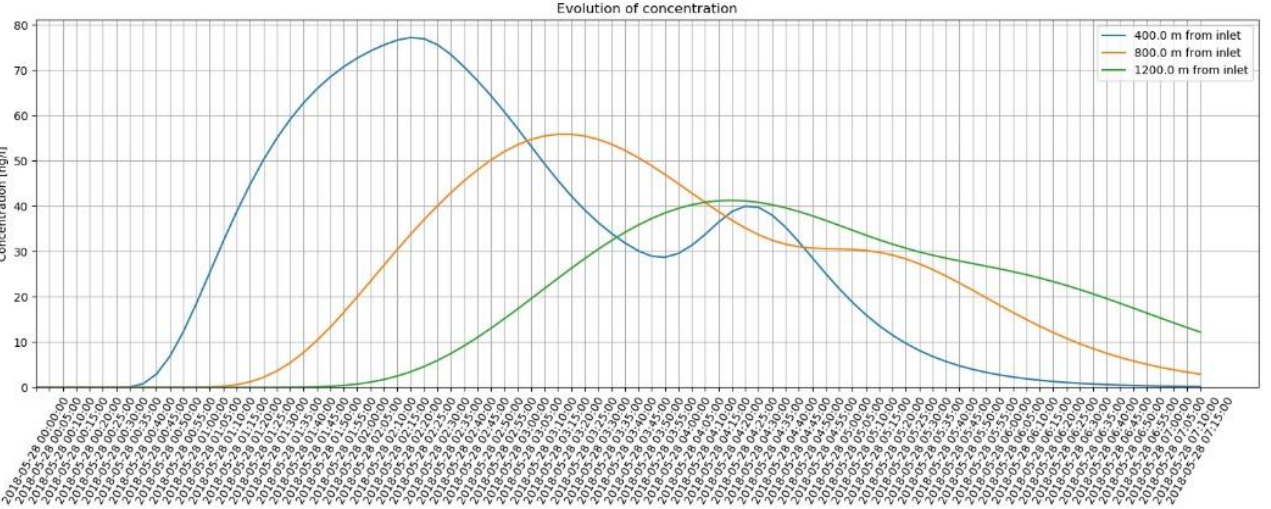
Figure 12. Simulated concentration at x = 400 m, x = 800 m, and x = 1200 m from the inlet point with 5 min time step length. Table 2. Data used in the test presented in Section 3.2.3. Date and Time C 0